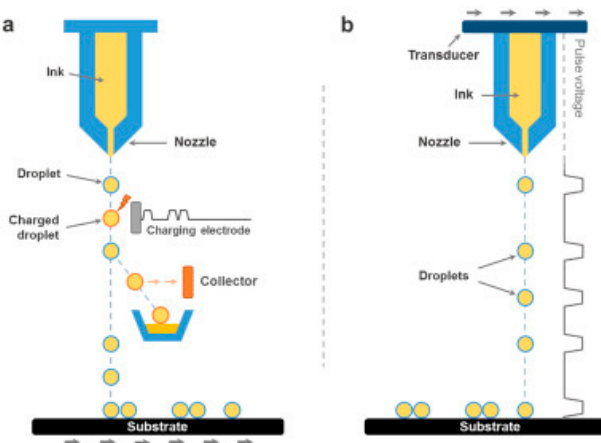
Figure 9. Schematic illustration of the ( a ) continuous mode and ( b ) drops-on-demand mode of inkjet printing. Reproduced with permission from Reference [37]. Copyright © 2018 Elsevier.